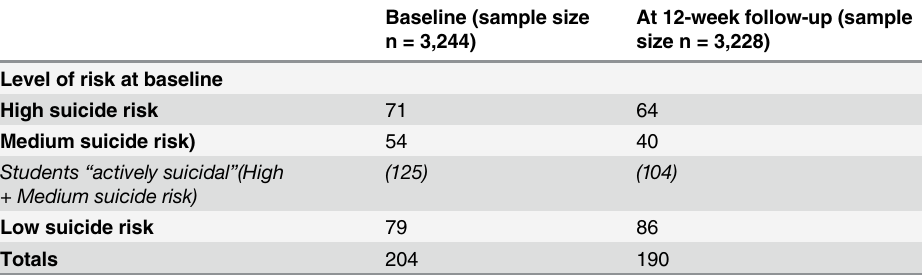
Baseline (sample size At 12-week follow-up (sample n = 3,244) size n = 3,228)